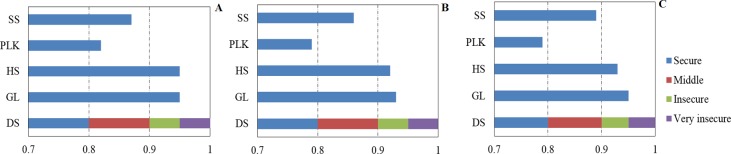
Calculated results of relative degree obtained by catastrophe model and modified catastrophe model in four study areas.The abbreviations are Gu Li village (GL), Hu Shu village (HS), Planck farm (PLK), Suo Shi village (SS) and dividing standard (DS). (A) final calculated data of the year 2011 under the setup catastrophe model; (B) final calculated data of the year 2012 under the modified catastrophe model; and (C) final data of the year 2012 under the modified model.